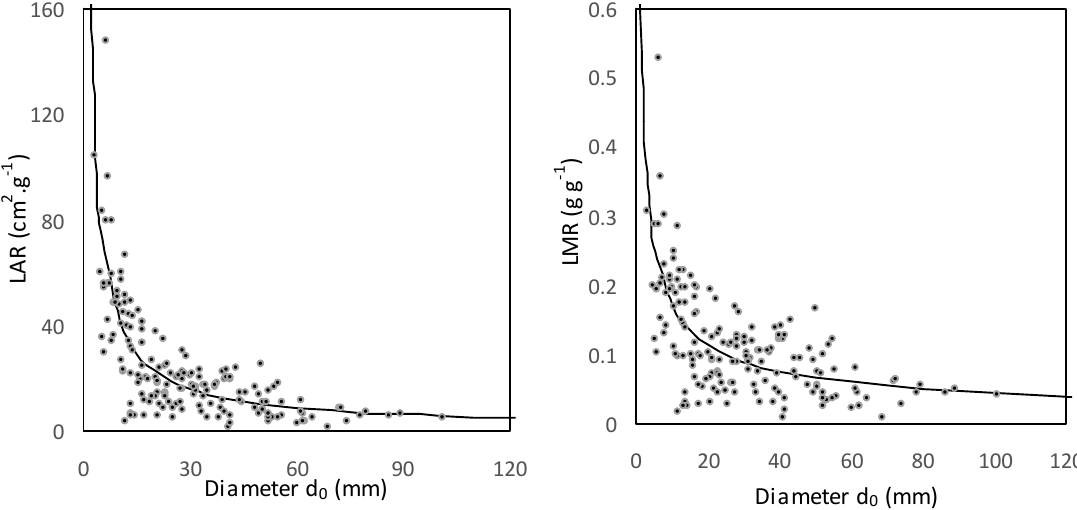
Figure 6. Leaf area ratio (left plate) and leaf mass ratio (right plate) plotted against the d 0 stem base diameter of the sampled common aspen trees (see also Table 3).